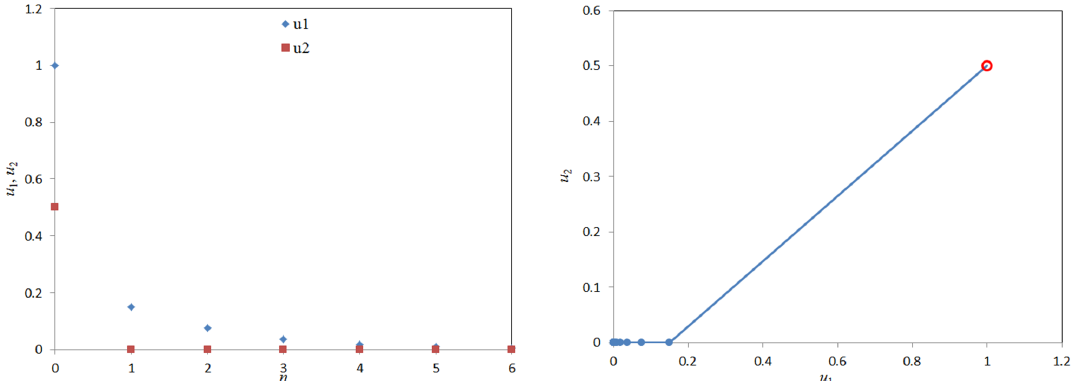
Figure 6. Dependencies u 1 ( t ) and u 2 ( t ) ( left ) and the phase trajectory of the worker-employer conflict ( right ) for 𝑢 ( 0 ) = 1; u ( 0 ) = 0.5; k = 0.3; k = 0.7; k = 0.4; and k = 0.5 ( λ = 1.01; λ = 0.089). The discrepancy u 1 corresponds to the worker while the discrepancy u 2 corresponds to the employer.